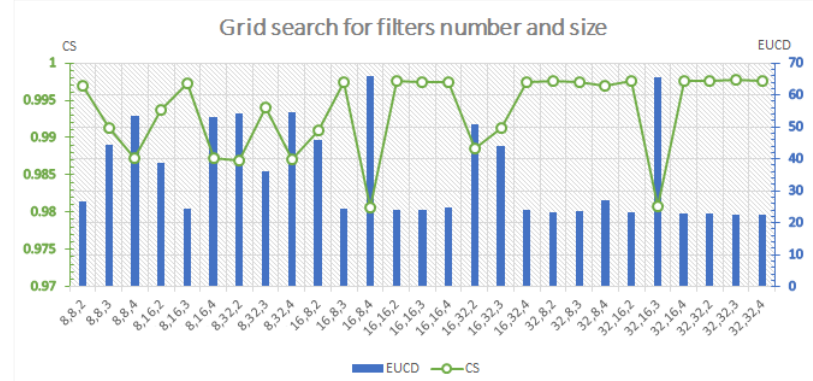
Figure 4. Grid search for number of filters and filters size.